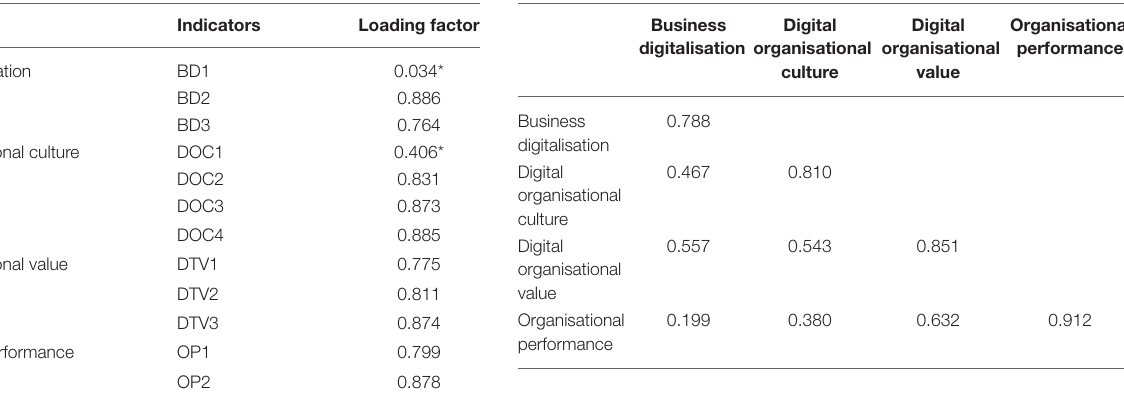
TABLE 1 | Convergent validity test.